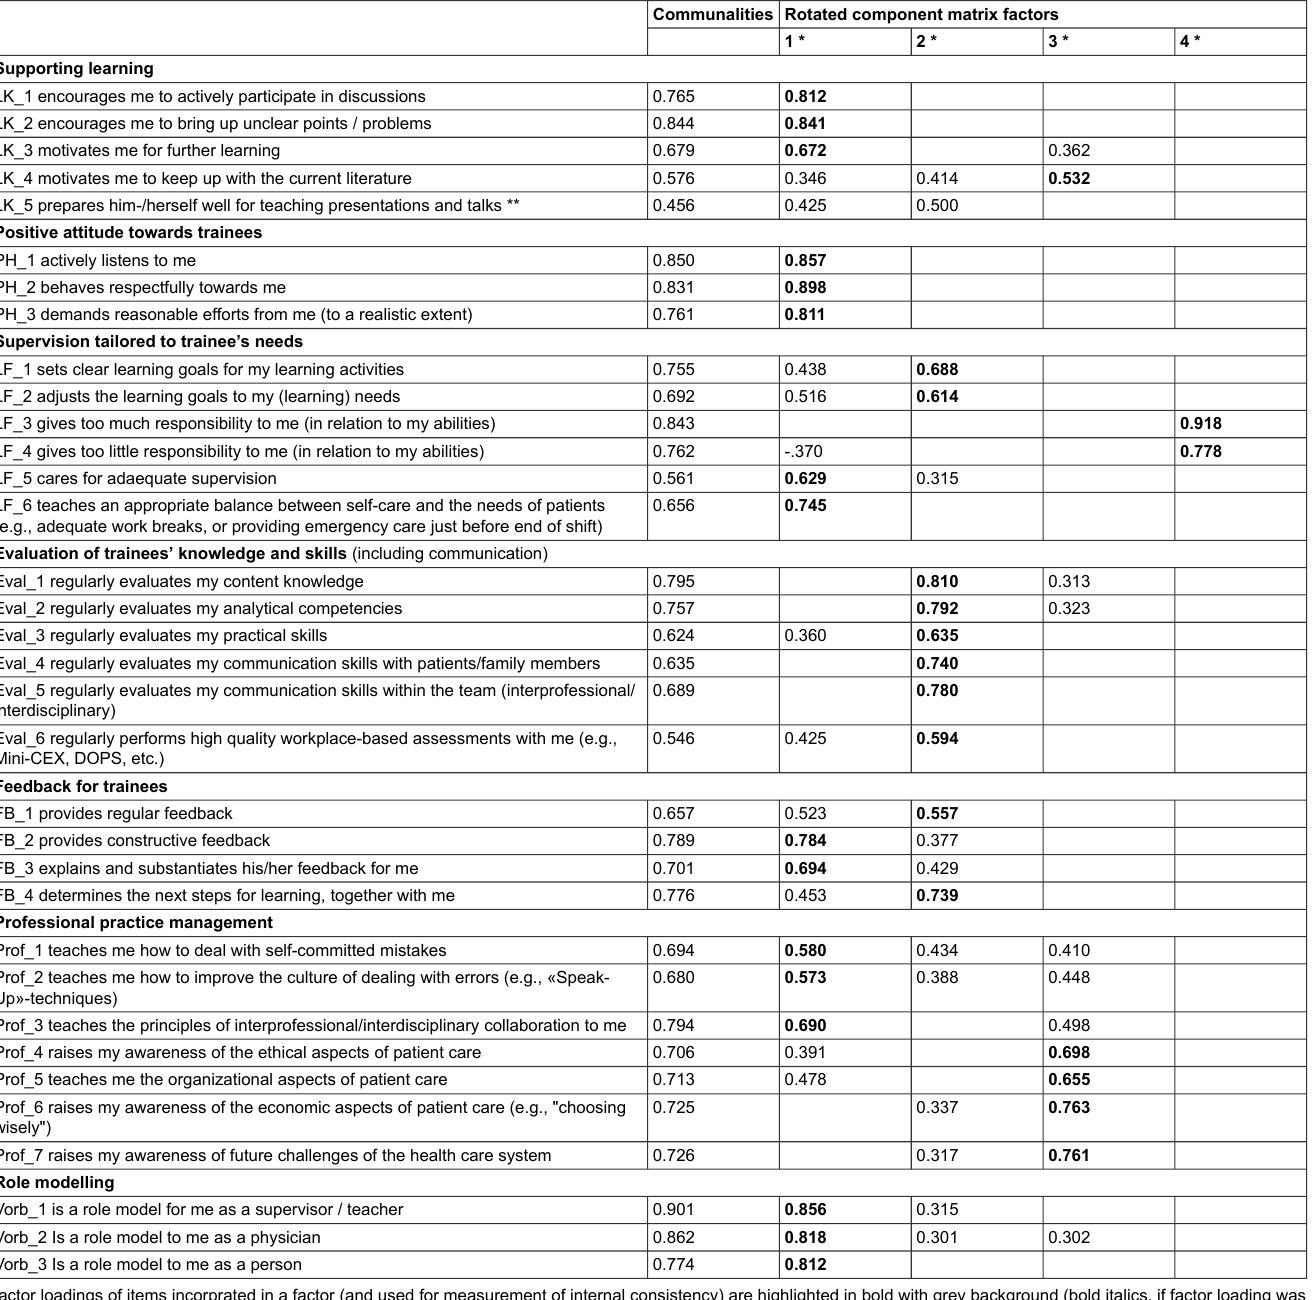
Communalities Rotated component matrix